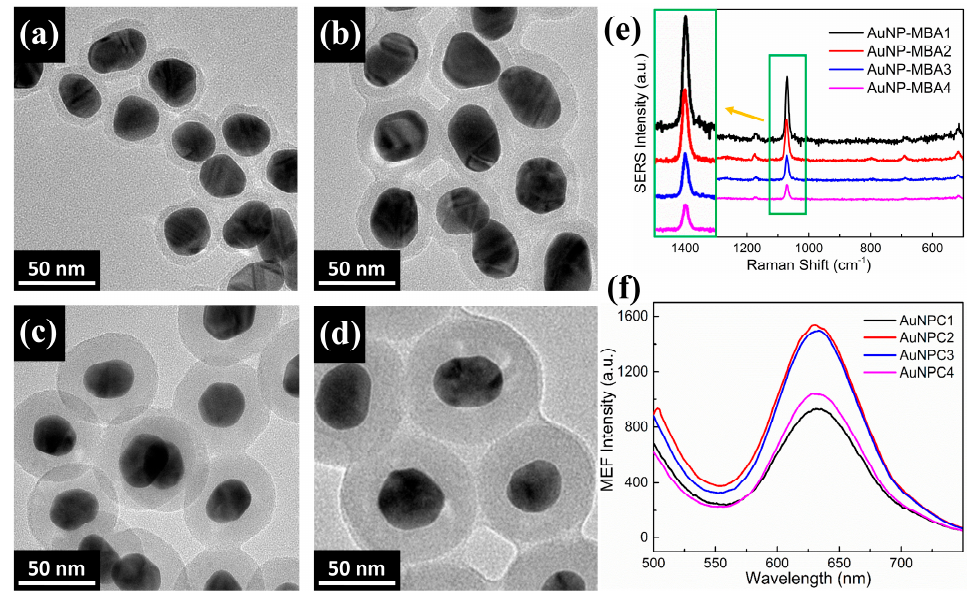
Figure 1. ( a – d ) TEM imaging of AuNP@SiO 2 -1-4; ( e ) SERS spectra of the AuNP-MBA1-4; ( f ) MEF spectra of the